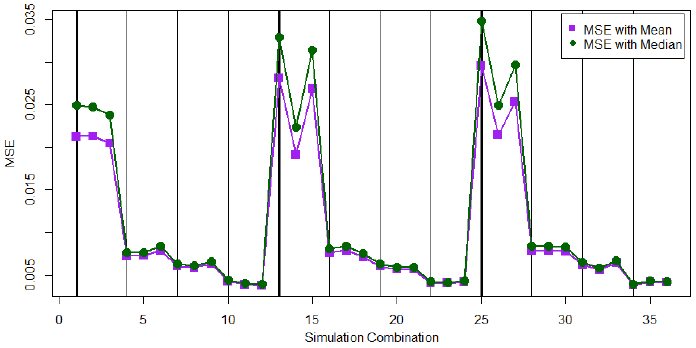
Figure 2. The expected square errors (ESEs) of ˆ δ SE and ˆ δ AE for the case of β 1 (cid:54) = β 2 .